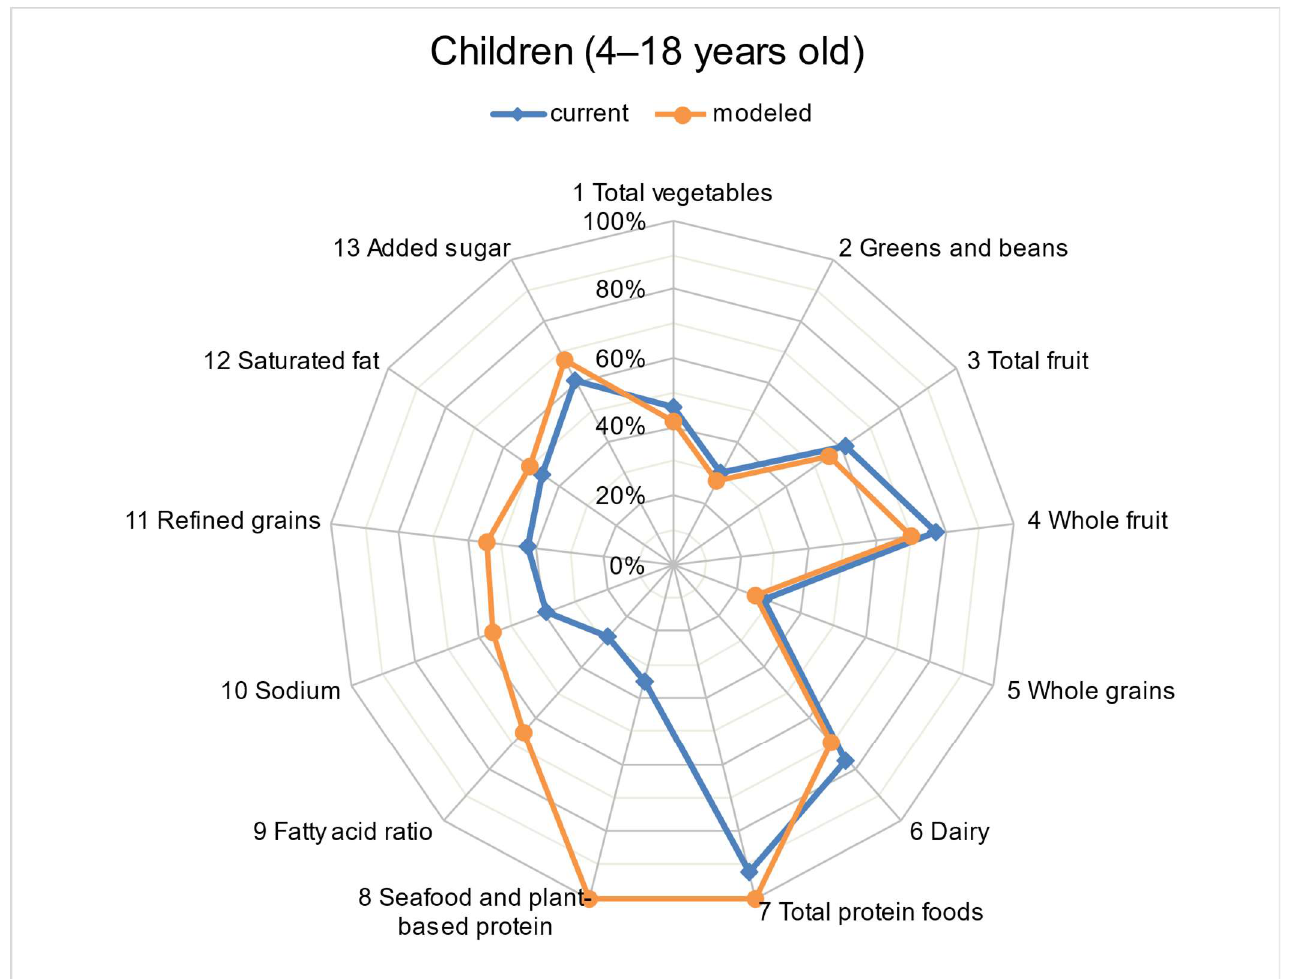
Figure 2. Radar plot to compare HEI-2015 * component scores (% of maximum possible score) between current intake and modeled intake (addition of 1 ounce of walnuts) among children aged 4–18 years. * HEI-2015 includes 13 dietary components. Nine adequacy components (those recommended for inclusion in a healthy diet) include total vegetables (5), greens and beans (5), total fruits (5), whole fruits (5), whole grains (10), dairy (10), total protein foods (5), seafood and plant proteins (5), and fatty acids ratio (10). Four moderation components (those that should be consumed sparingly) include sodium (10), refined grains (10), saturated fats (10), and added sugars (10) (21).